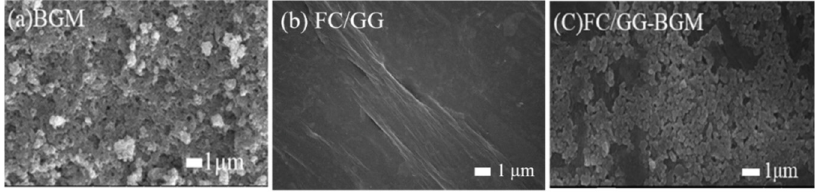
Figure 2. Scanning electron microscopic images for surface morphological observation of ( a ) pure BGM particles, ( b ) FC/GG membrane, and ( c ) FC/GG-BGM membrane. BGM particles, ( b ) FC/GG membrane, and ( c ) FC/GG-BGM